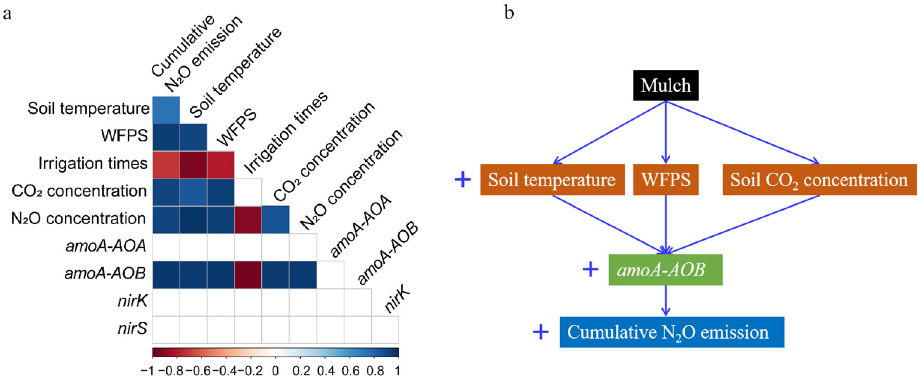
Figure 6. Correlations of cumulative N 2 O emission with soil temperature, WFPS, irrigation times, soil CO 2 concentrations, soil N 2 O concentrations, and abundance of amoAAOA , amoAAOB , nirK , and nirS genes ( a ). Conceptual diagrams showing regulators and controls of black plastic film mulching effect on cumulative N 2 O emission ( b ).